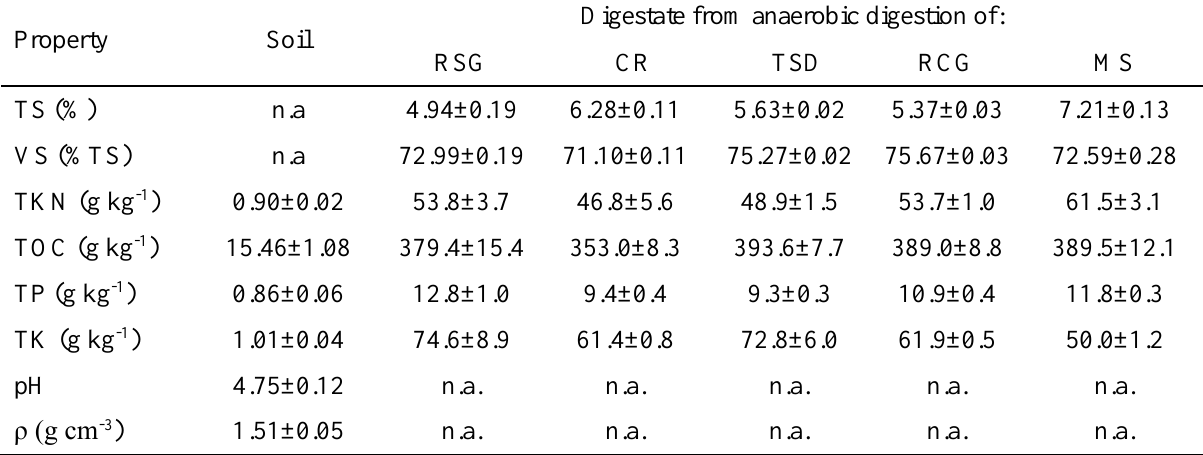
Table 1. Main physical and chemical characteristics of soil used for the incubation experiment and characteristics of the digestate from anaerobic digestion of reed sweet-grass (RSG), common reed (CR), tufted sedge (TSD), reed canary grass (RCG) and maize (MS); mean value ± standard deviation, data expressed on a dry weight basis. TS = total solids, VS = volatile solids, TKN = total Kjeldahl nitrogen, TOC = total